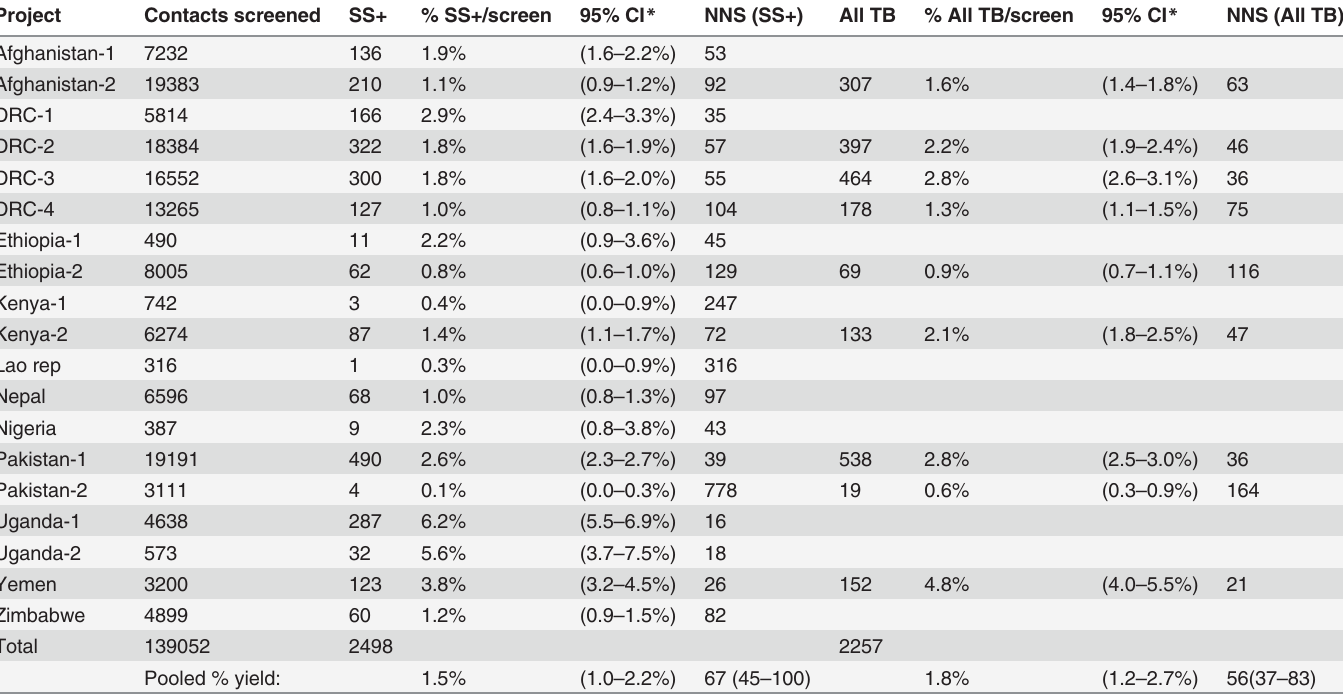
Table 2. Number of people screened and number of smear positive (SM+) and all forms of TB identi fi ed through contact investigation in 19 projects.